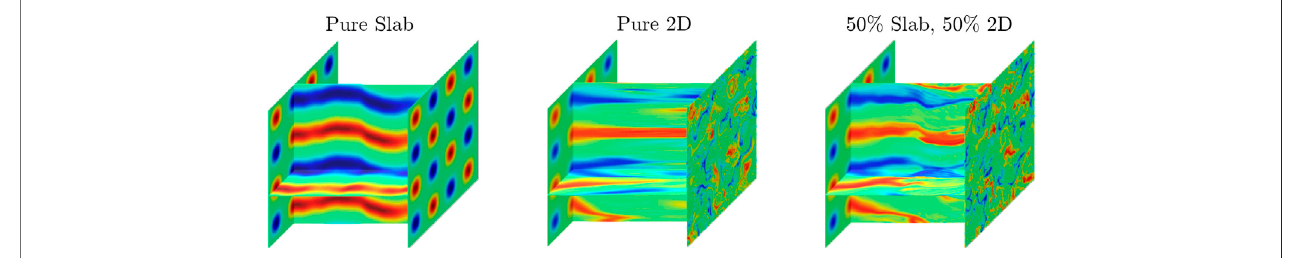
FIGURE 3 | After Bieber et al. (1996), simulations of magnetic fl ux tubes perturbed by three types of fl uctuations (injected at the left of each box), which evolve into vastly different structures.